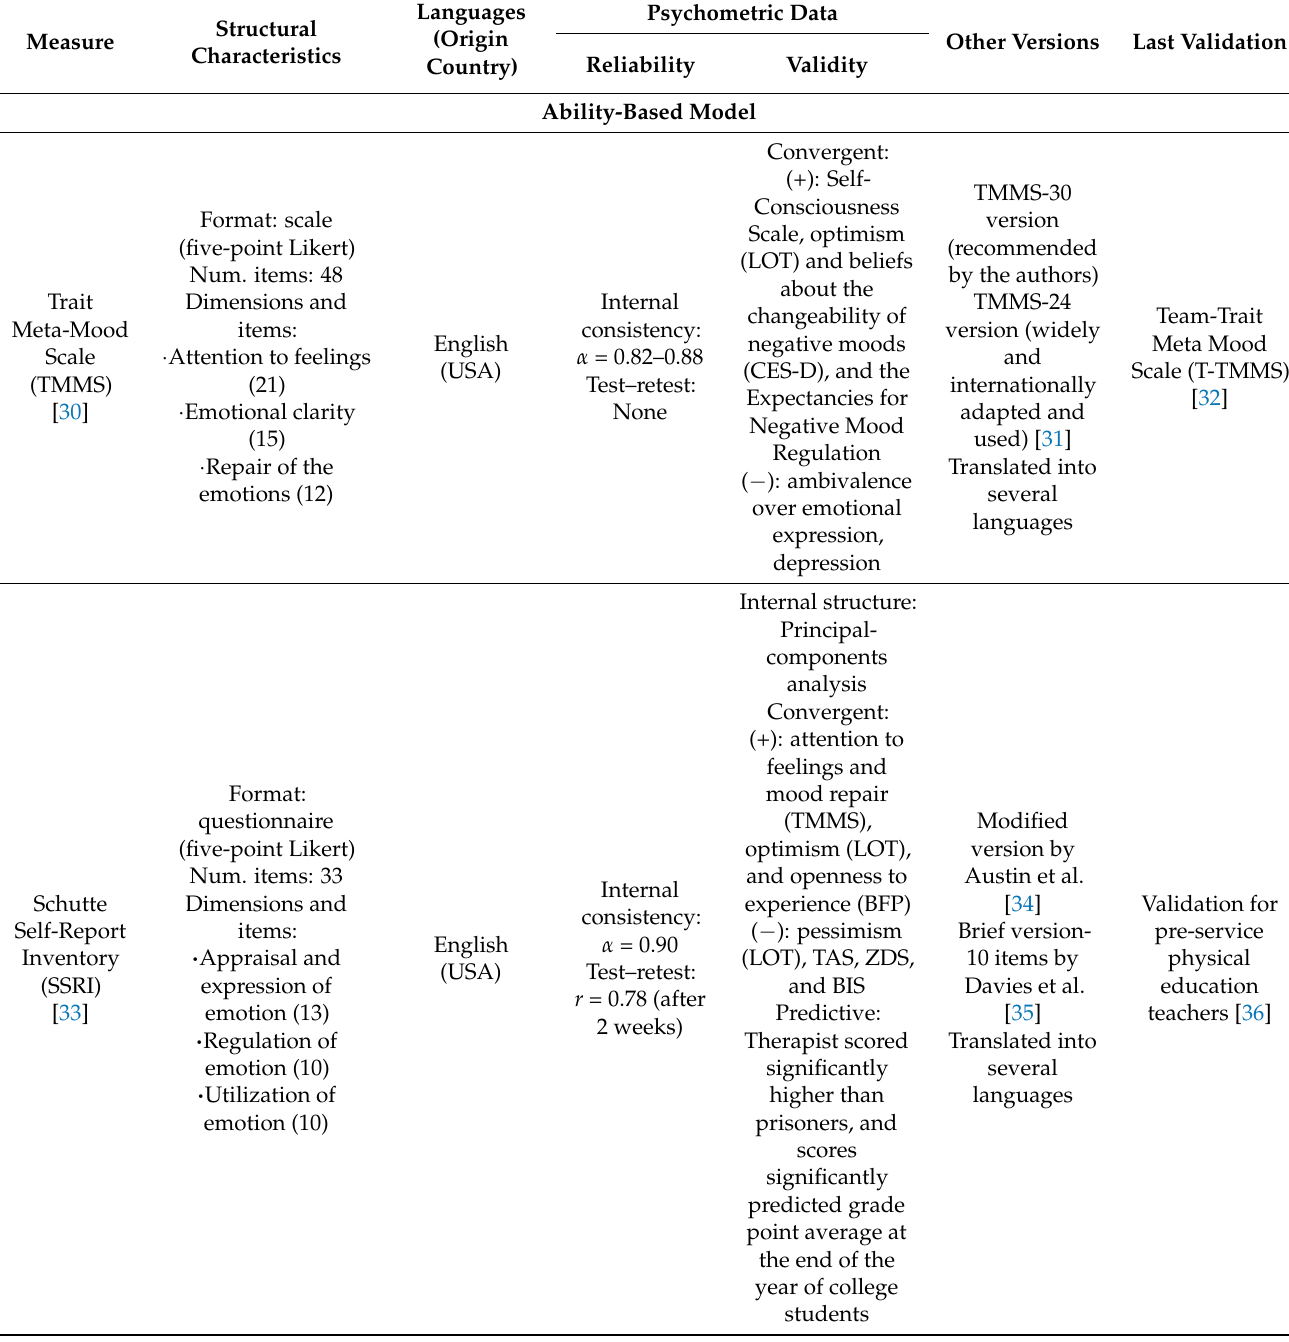
Table 1. Main characteristics of the included